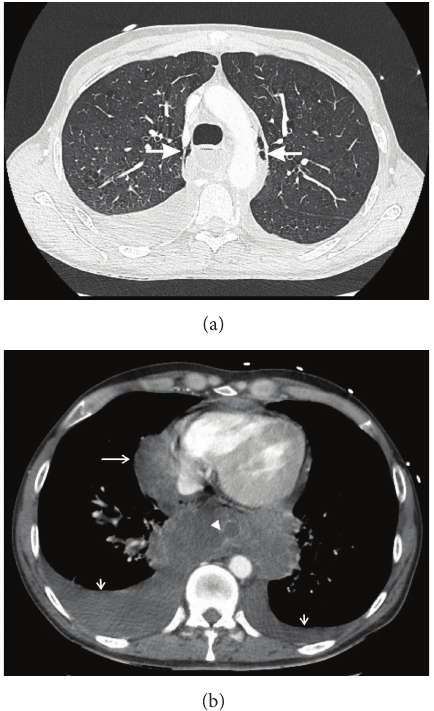
Figure 2: Contrast-enhanced CT scan of the thorax: (a) lung window, confirming pneumomediastinum (closed arrows), and (b) mediastinal window showing a tear in the right posterolateral wall of the distal oesophagus (arrowhead), bilateral pleural effusions (short arrows), massive retrocardiac collections, and a paracardial collection (open arrow) corresponding with the silhouette sign on chest X-ray.